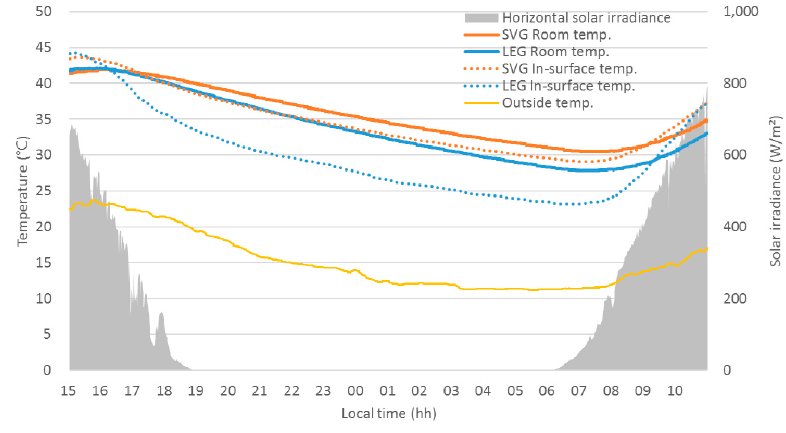
Figure 4. Measured temperature profiles with the SVG and LEG (8–9 April 2017).